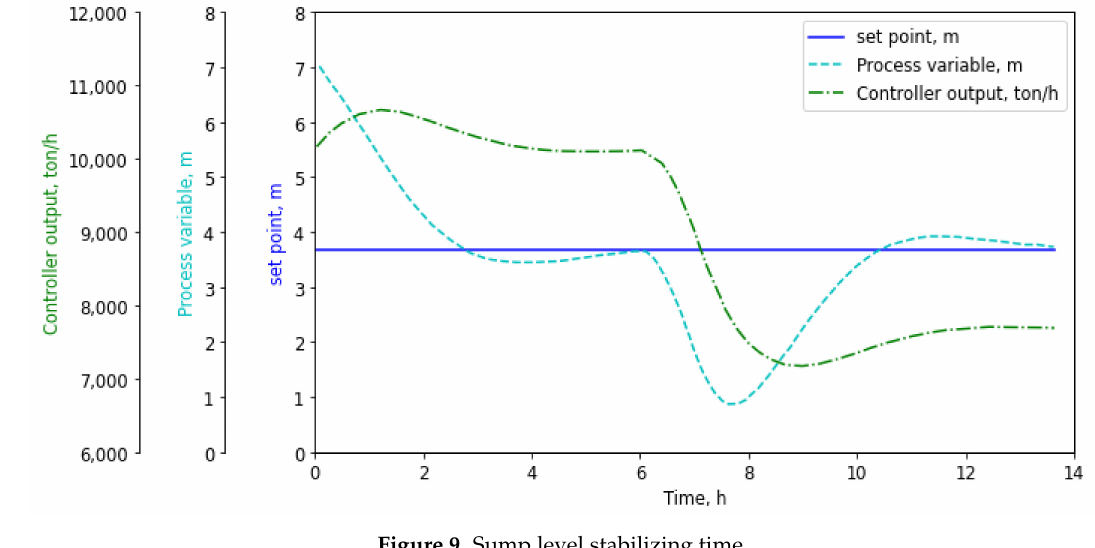
Figure 9. Sump level stabilizing time.